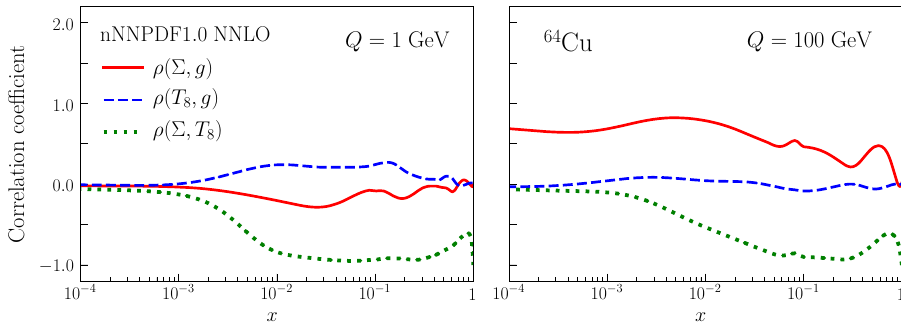
(cid:22) (cid:21) (cid:14) f j − (cid:13) f j (cid:14) ted green line). The coefficients are computed with N rep = 200 replicas of the copper ( A = 64) nNNPDF1.0 NNLO set at Q = 1 GeV (left) and Q = 100 GeV